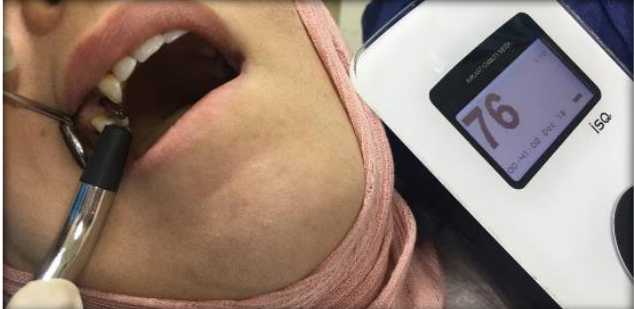
Figure 2: Implant stability measurement using Osstell ®